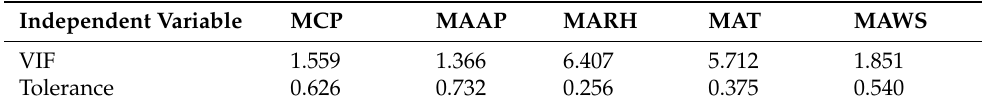
Table 2. Result of colinearity statistics.